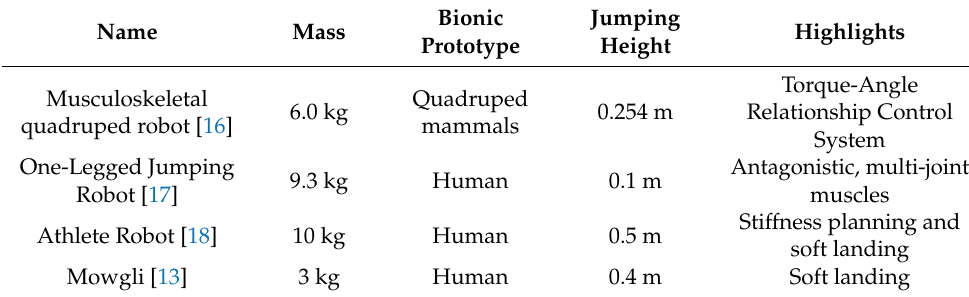
Table 1. Bionic jumping robots driven by pneumatic artificial